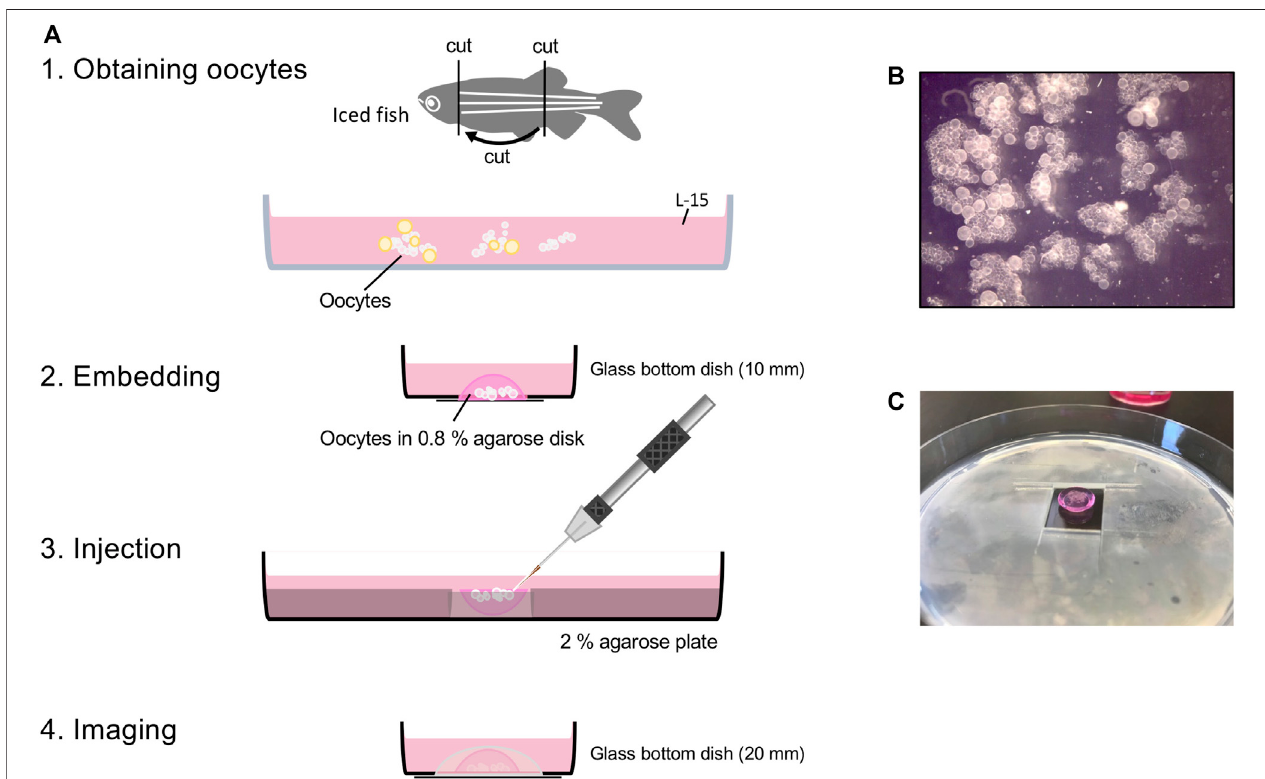
FIGURE1| Work fl owofoocyte injection. (A) Obtainingoocytes fromjuvenileoradultfemale fi sh. Embeddingsmallclumpsofovarythathasonlystage Ioocytes in 0.8%agarosedisk (B) .Forinjection,0.8%agarosediskisplacedintheholeofthe2%agaroseplate,sotheoocytesfaceup (C) .Afterinjection, fl ip0.8%agarosediskso oocytes face down onto glass bottom dish for